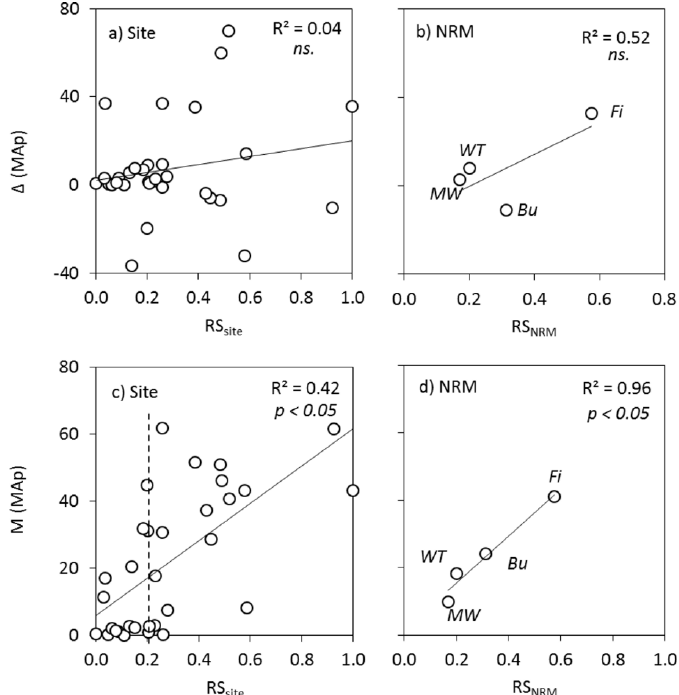
Figure 9. Multi-annual (2005–2014) changes in ( Δ : a , b ) and mean (M: c , d ) MAp compared to risk scores (RS) at the site ( left ) and NRM scales ( right ). ns. non-significant. The dotted line in ( c ) indicates an initial risk score threshold of about 0.2, below which there is rarely high MAp at the reef sites.